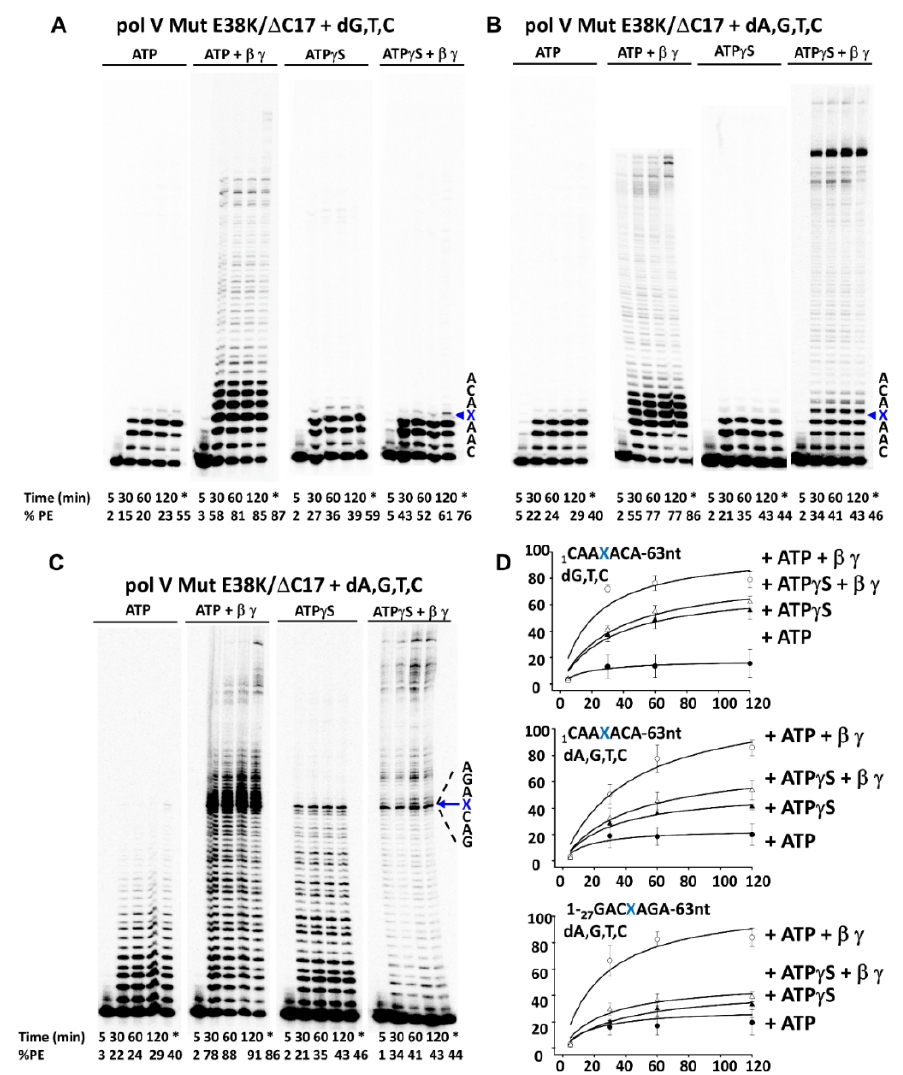
Figure 5. Trans-lesion synthesis (TLS) by Pol V Mut E38K/ ∆ C17 on p/t DNA containing an abasic site. ( A , B , C ) TLS of pol V Mut WT (400 nM) was measured on circular p/t DNA (20 nt primer/ 90 nt circle; 25 nM) in the presence and absence of β -clamp and γ -complex with saturating concentration of ATP/ATP γ S (500 µM) and with two sets of dNTPs: ( A ) dGTP, dTTP, dCTP and ( B , C ) dATP dTTP, dCTP, dGTP (500 µM each). ( A , B ) Activity of pol V Mut WT on p/t containing an abasic site 3 nucleotides away from 3’-OH of primer. ( C ) activity of pol V Mut WT on p/t containing abasic site 30 nucle- otides away from 3’-OH of primer. The abasic site is marked by an X. Samples were taken at different times to measure DNA synthesis and at 120 min 400 nM of RecA * was added to the reaction to trans -activate the mutasome which is represented by *. The experiments were repeated 3 times and the average % PE (percent p/t DNA extended) with the SD (standard deviation) for each reaction time point is graphed in panel ( D